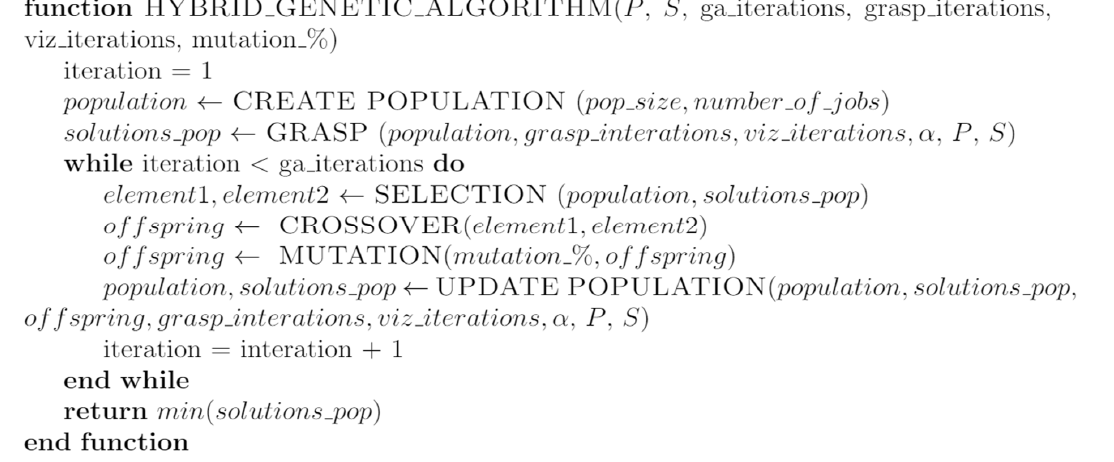
Fig. 2. Hybrid Genetic Algorithm